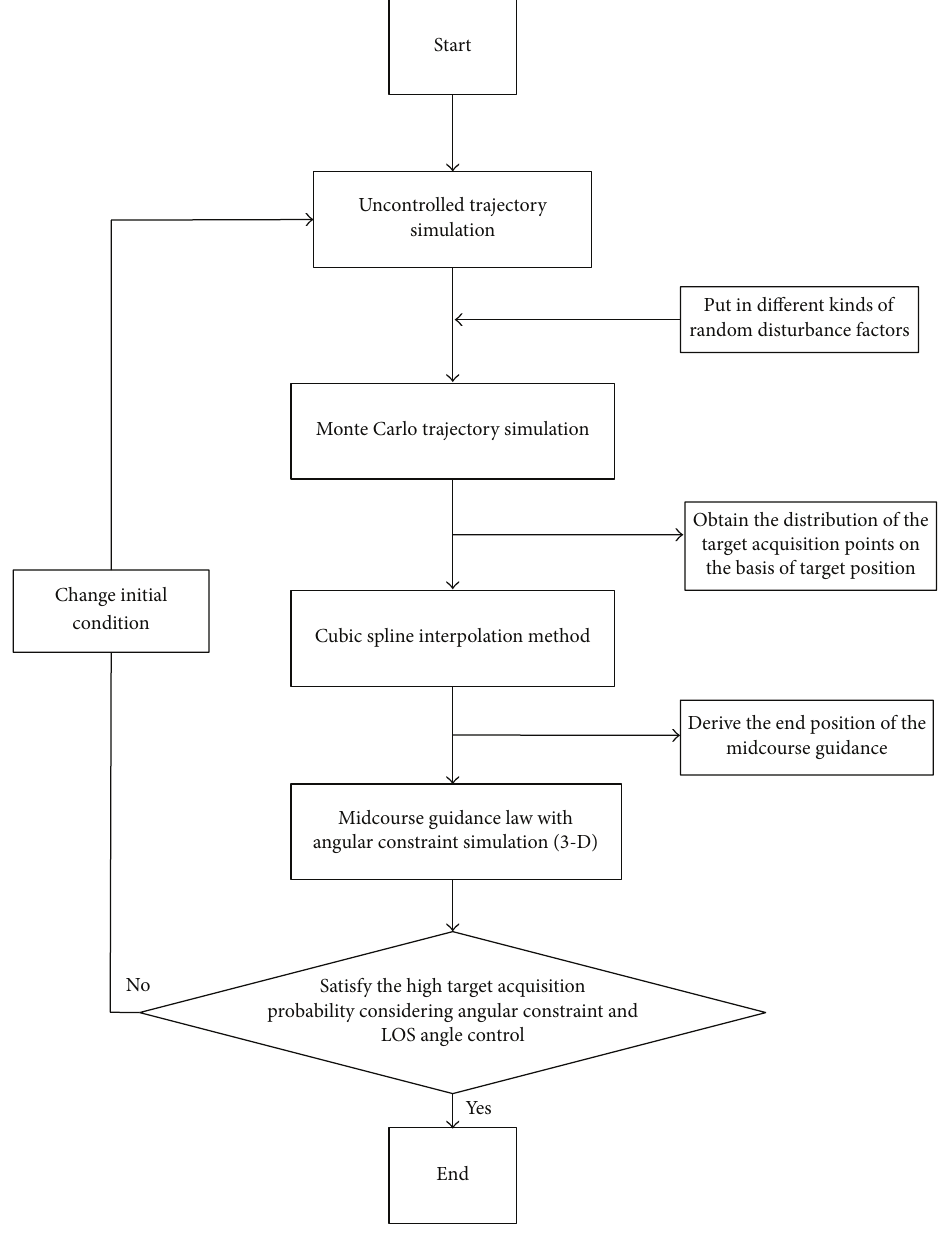
Figure 11: Simulation flow